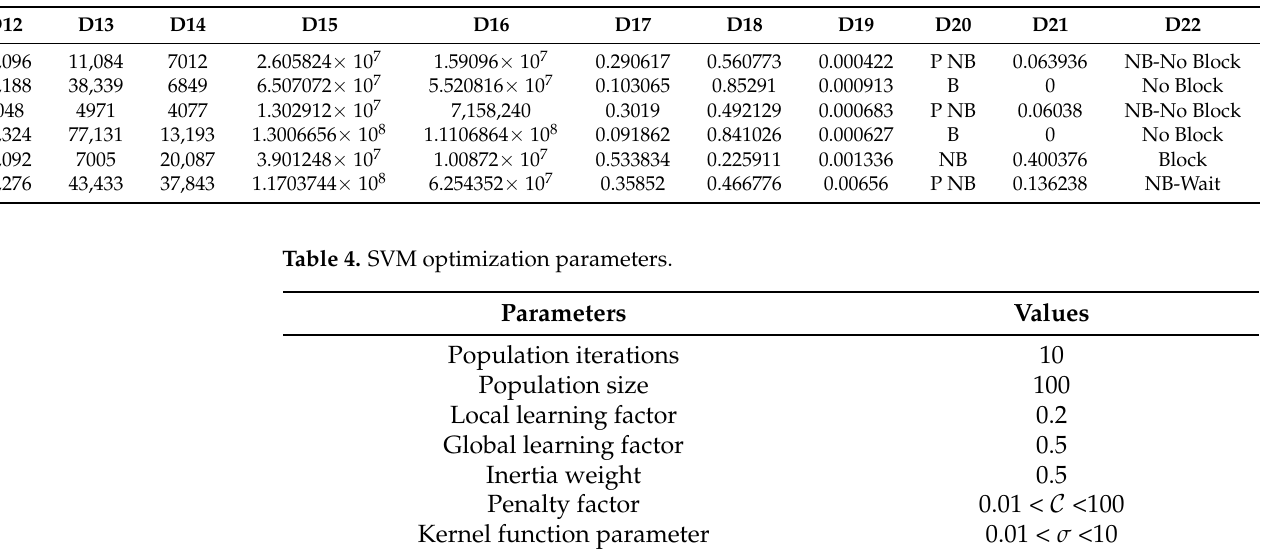
Table 3. Partial dataset (Part II).